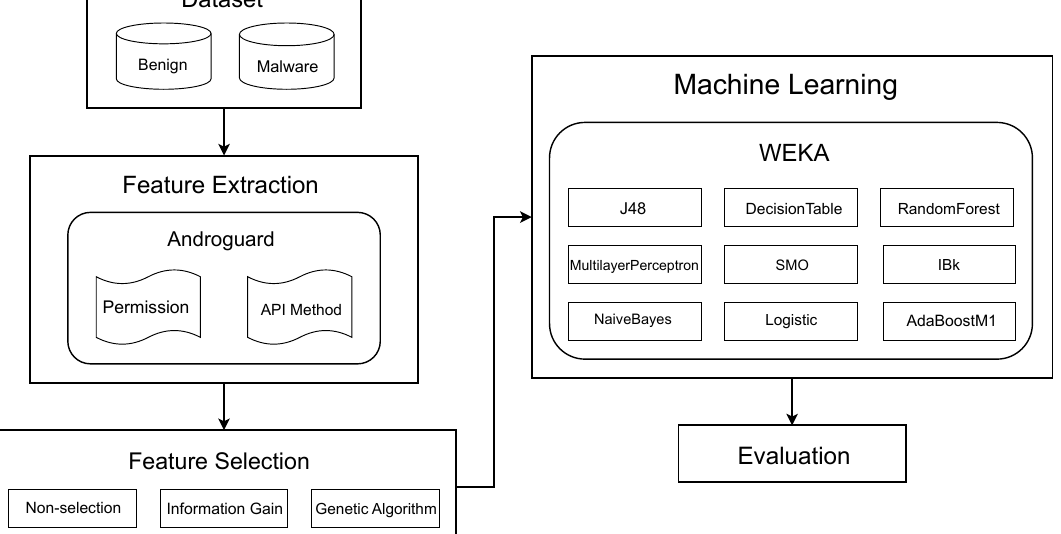
Figure 3. Flowchart of experiment progression.